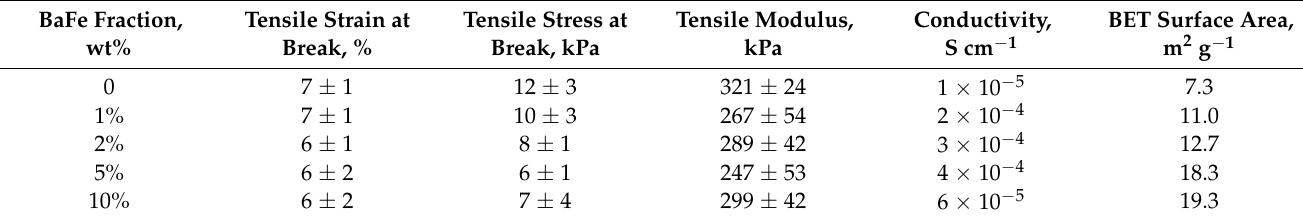
Table 2. Mechanical properties (cryogels), conductivity and specific surface area of PPy-G aerogel and PPy-G-BaFe aerogels, synthesized using various fractions of BaFe. BaFe Fraction,